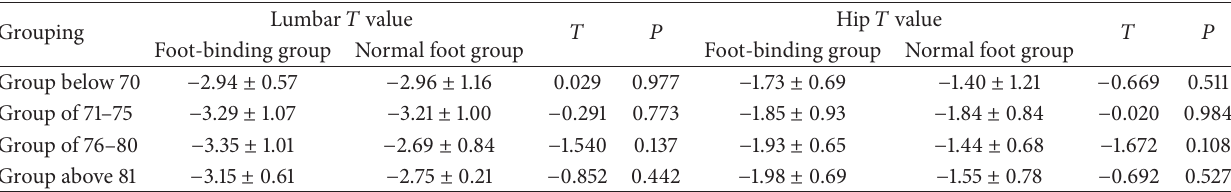
Table 8: Comparison of 𝑇 values of the lumbar spine and hip 𝑇 values in the different age groups between normal foot group and foot-binding